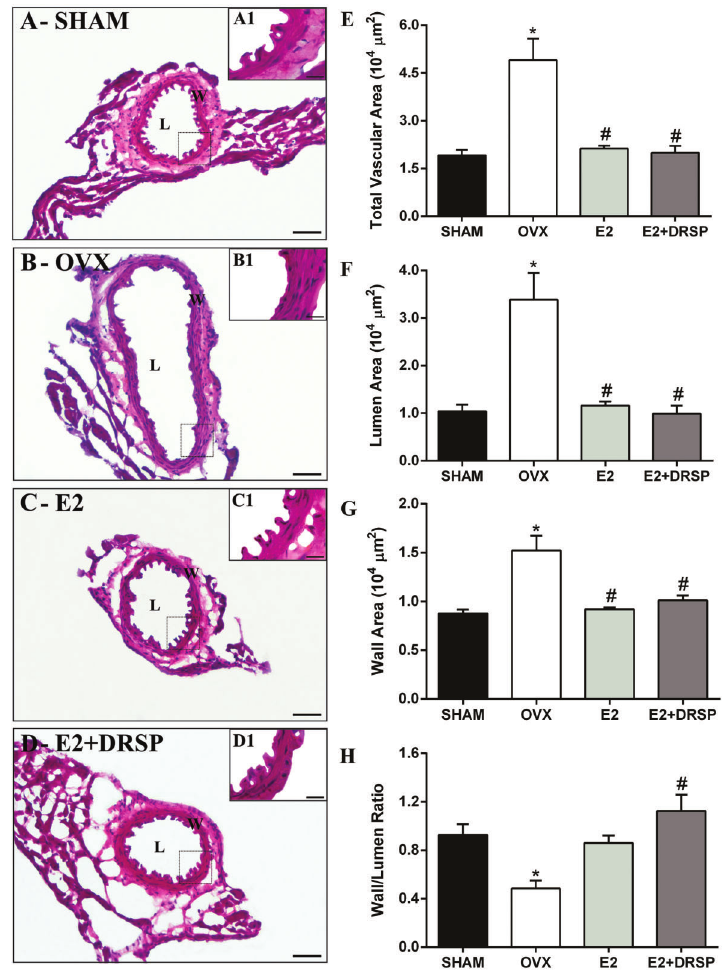
Figure 3. Histomorphometric analysis of coro- nary arteries from ovariectomized spontaneously hypertensive rats. Representative images of histological slices of the coronary arteries: SHAM ( A and A1 ), OVX ( B and B1 ), E2 ( C and C1 ), DRSP ( D and D1 ) groups. Total vascular area ( E ), lumen area ( F ), vessel wall area ( G ), and the wall to lumen ratio ( H ) are reported as means ± SE (n=4 per group). OVX: ovariectomized; E2: estrogen; DRSP: drospirenone; L: vessel lumen; W: vessel wall; total vascular area: L + W area. *P o 0.05 compared to Sham, # P o 0.05 com- pared to OVX (one-way ANOVA followed by Tukey ’ s post hoc test). Bars: 50 and 20 m